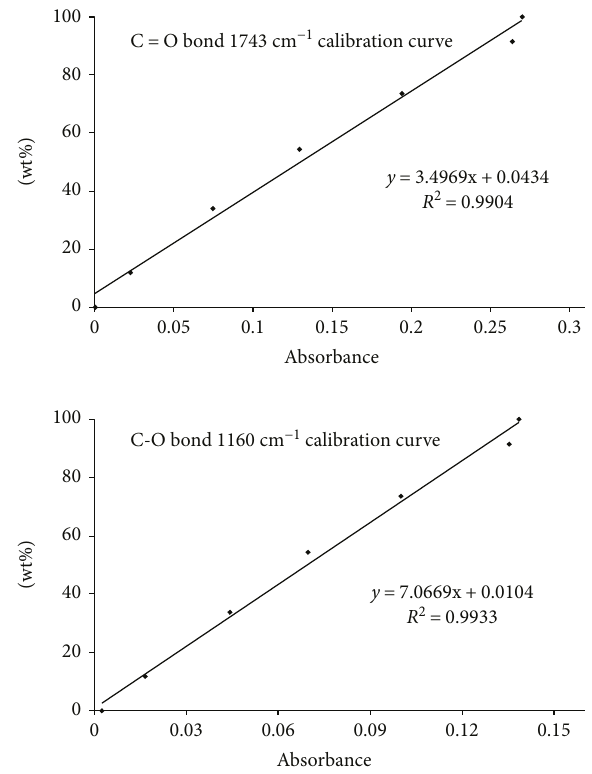
Figure 2: Calibration curve of Jatropha curcas seed oil dilutions with hexadecane at 1743 and 1160cm − 1 wavelength [12].